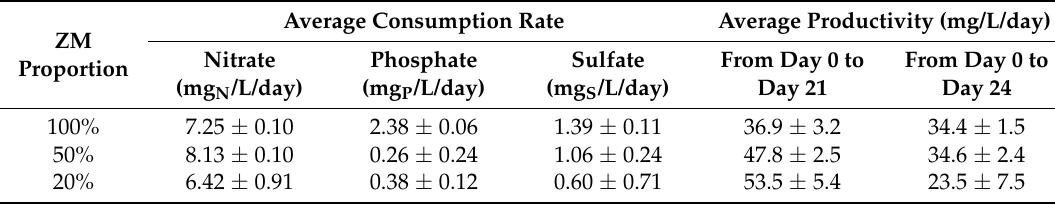
Figure 5. Nitrate concentrations in mgN-NO 3 − /Lin 100% (blue diamonds), 50% (red squares), and 20% (green triangles) modified ZM growing Spirulina, triplicates. Table 3. Average nutrient consumption rate for 100%, 50%, and 20%-modified ZM.